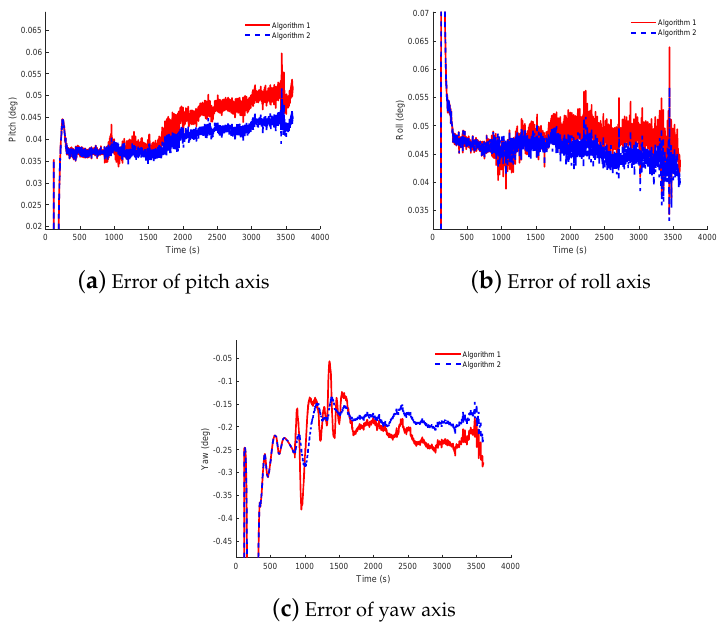
Figure 10. Attitude error curves with different initial alignment algorithms. ( a , b ) are the error comparisons of the horizontal attitude angles and ( c ) is the error comparison of the azimuth angles. The red solid line denotes the angle error curve with the CKF fine alignment algorithm while the blue dashed line denotes the angle error curve with the RHCKF fine alignment algorithm.